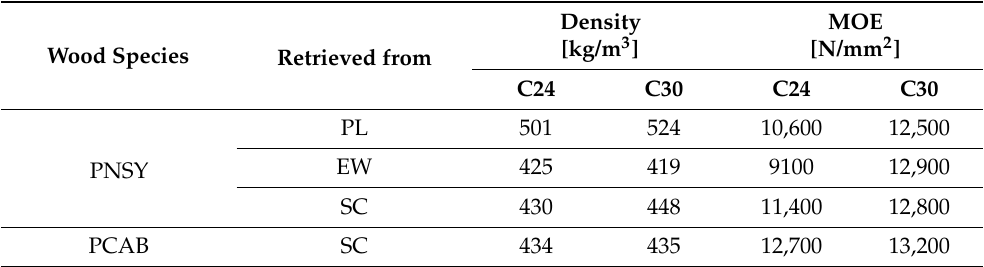
Table 3. Material data used in the analysis of numerical models of D version short frames made of solid wood